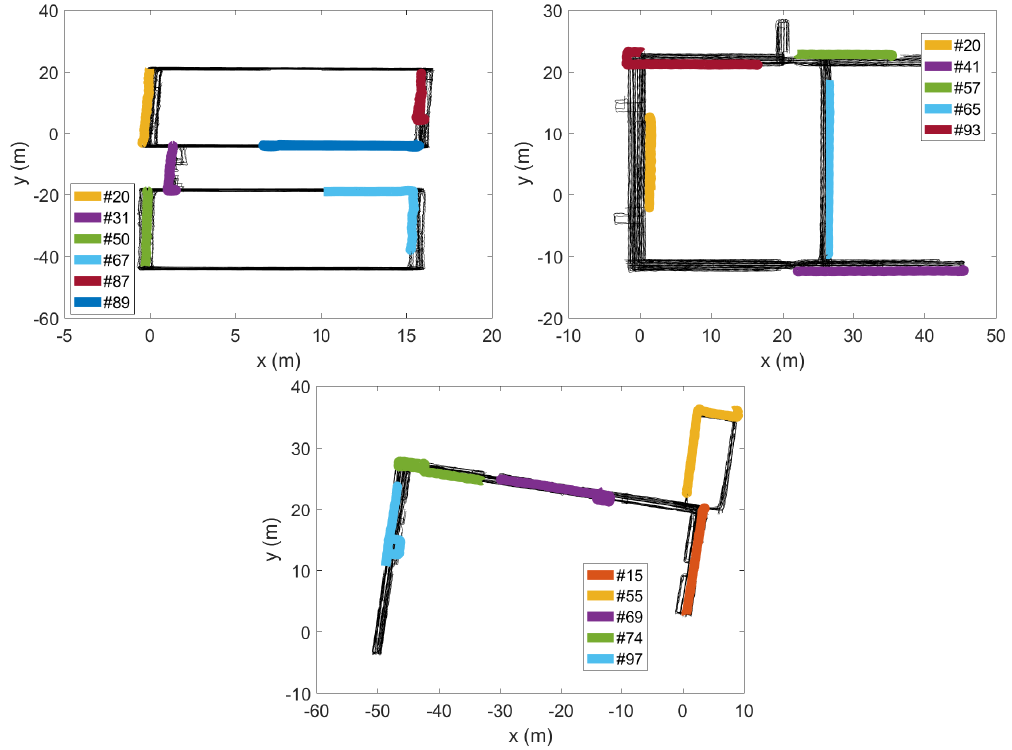
Figure 11. Non-coexistent traces selected from CSL ( top left ), Loomis ( top right ), and Talbot ( bottom